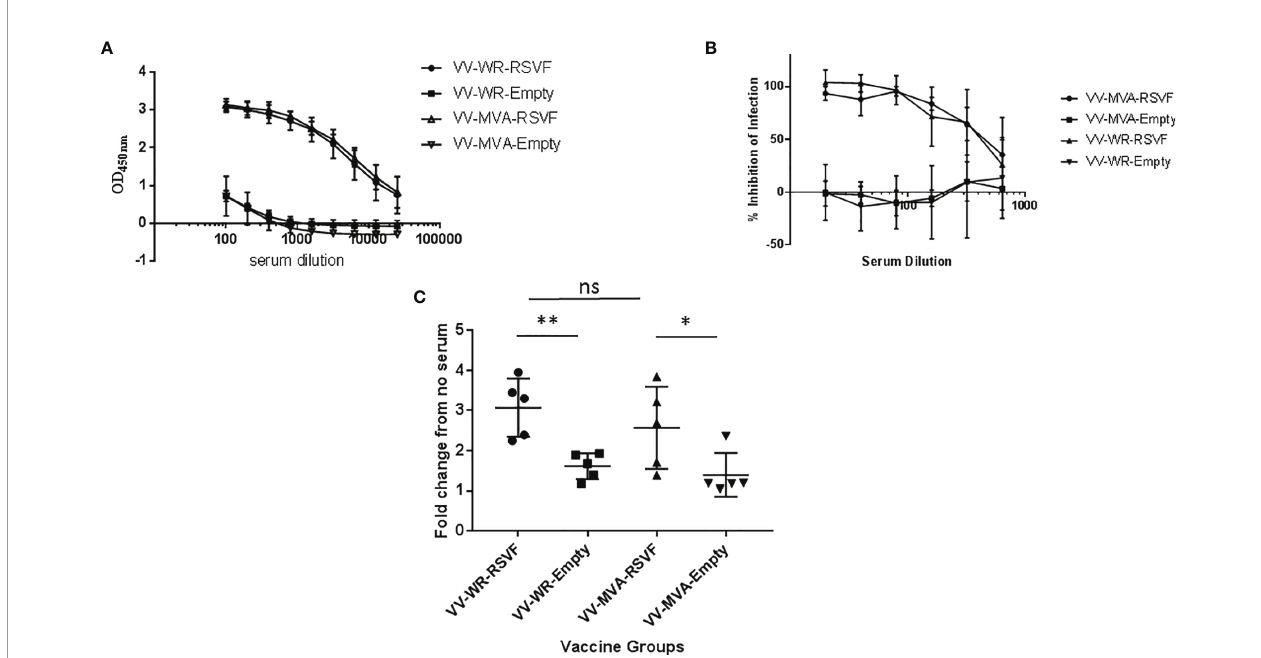
FIGURE 4 | VV-WR-RSVF induces robust humoral response to RSV-A2 challenge in Cotton Rats. Cotton rats were intramuscularly immunized with one dose of 10 7 PFU of the indicated VV-WR or VV-MVA constructs and intranasally challenged with 10 6 PFU of RSV-A2 and necropsied 5 days later with n = 5 cotton rats per treatment group. Serum was collected and (A) F-speci fi c total IgG in the serum of vaccinated cotton rats 5 days post-challenge was determined using ELISA (n=5). (B) RSV neutralizing ability and (C) RSV Antibody-dependent cell-mediated cytotoxicity (ADCC) ability of the cotton rat serum collected 5 days post-challenge (n=5 each) were also evaluated. *p < 0.05, **p < 0.01 (non-parametric t-test Mann-Whitney). ns, not signi fi cant.